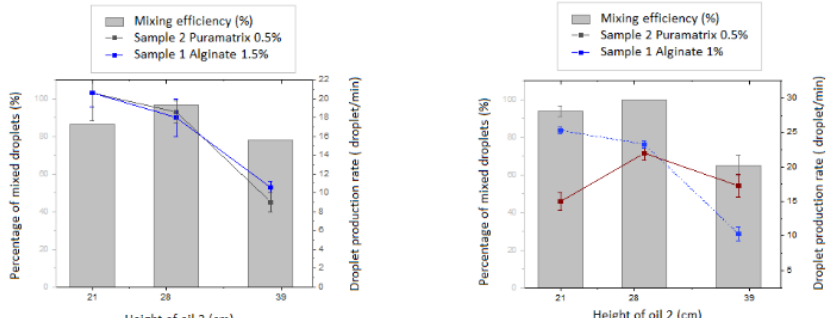
Figure 2. Characterization for the double layered device operational conditions using droplet different combinations of Puramatrix(0.3%) and alginate left: (1.5%) and right:(1%) containing calcium nano powder (1 wt%).